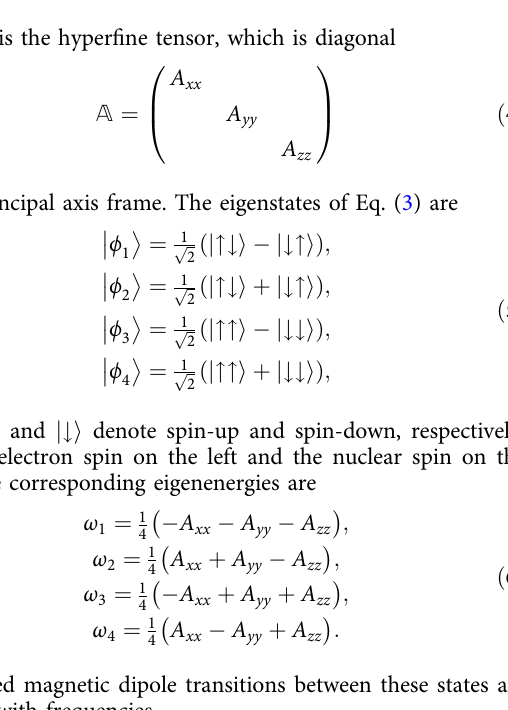
Fig. 2 State evolution of the NV center with continuous driving. a Pulse sequence for Rabi measurement. Green boxes denote the laser pulses used to polarize and read out the NV center. Orange box denotes the microwave pulse used to drive the NV states. b Pulse sequence for spin-locking measurement. Two additional π /2 pulses with 90° phase difference (brown boxes) are added before and after the continuous driving. c Measured Rabi oscillation. A modulated sine fi t gives the Rabi frequency of 396 MHz. Error bars indicate ±1 standard error of the mean (s.e.m), which is induced by the photon shot noise. Here, error bars are smaller than the symbols, as the sequence is repeated 40 thousand times to get enough photons. d Measured spin- locking relaxation. The driving power Ω = 148 MHz. An exponential decay fi t gives a relaxation time of 70 ± 2 μ s. Error bars (±1 s.e.m.) are smaller than the symbols. The sequence is repeated 60 thousand